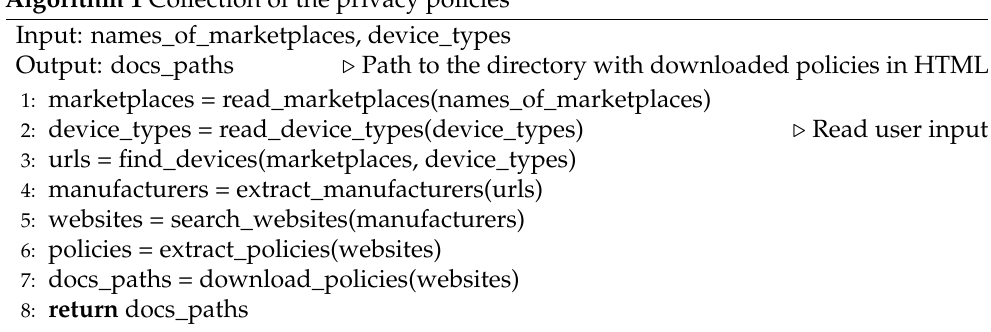
Algorithm 1 Collection of the privacy policies